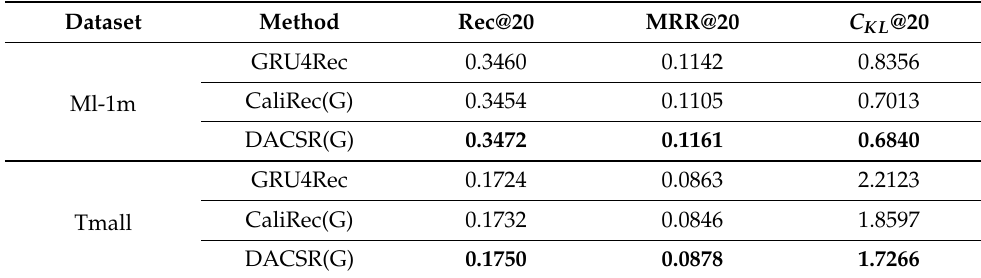
Table 4. Performances of our DACSR(G) model with the GRU4Rec sequence encoder (best perfor- mances are marked in